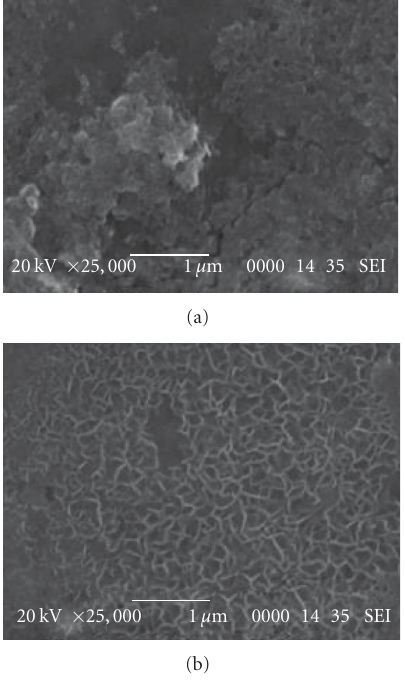
Figure 9: E ff ect of voltammetric cycling on the microstructure of MnO 2 films (a) before cycling; (b) after